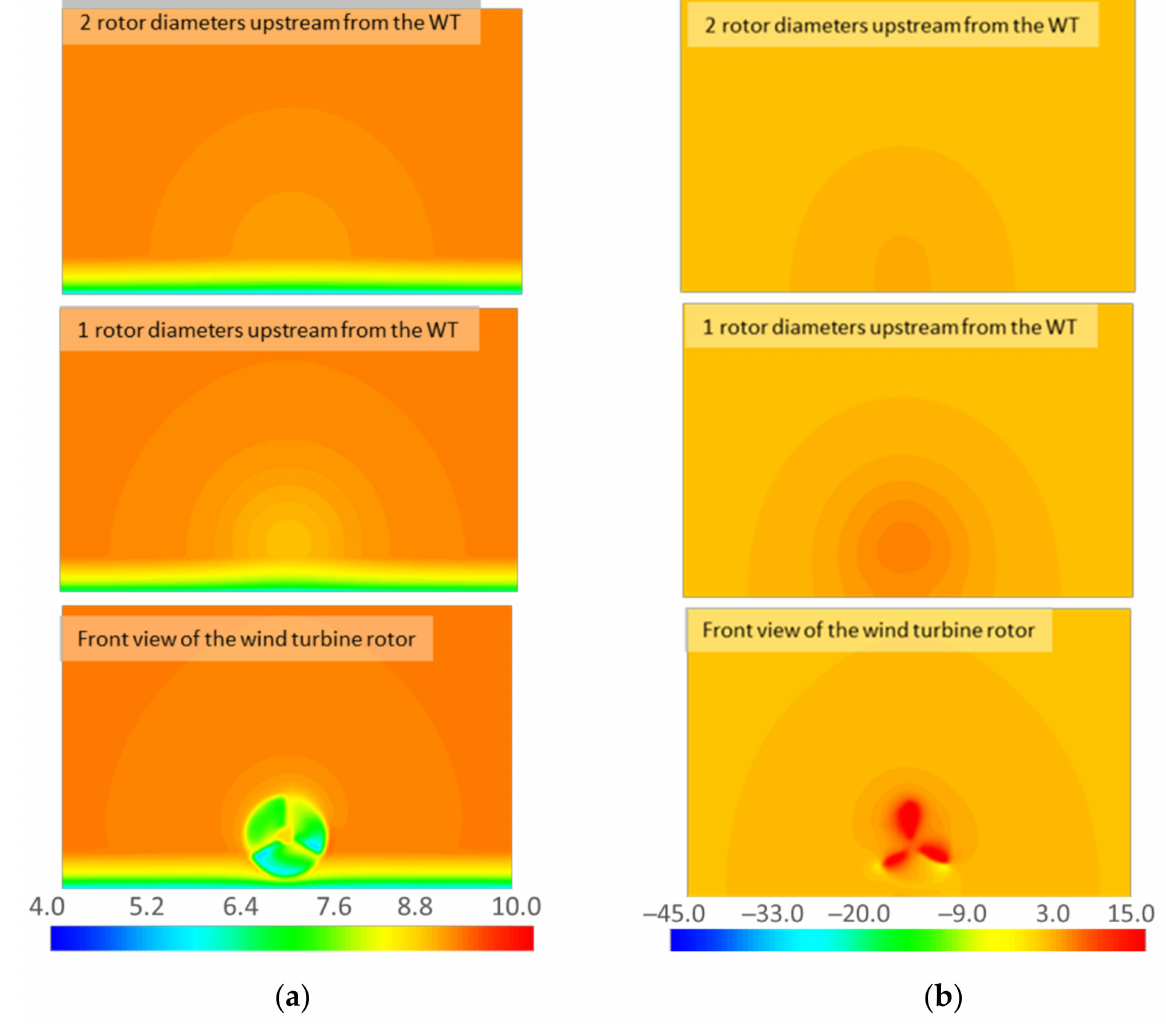
Figure 4. Upstream wind flow approaching the wind turbine: ( a ) speed; ( b ) static